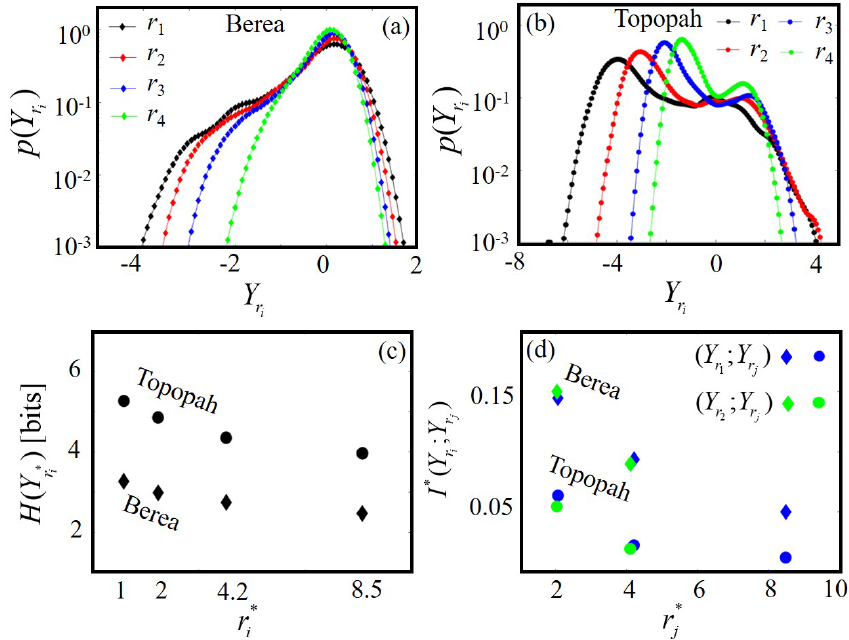
) , for various support scales, r i ( i = 1 (black), i ) versus r ∗ for the Topopah (circles) i i ; Y r ; Y r ) = I(Y r )/H(Y r ) between data at a reference i j i j i , considering the Berea j